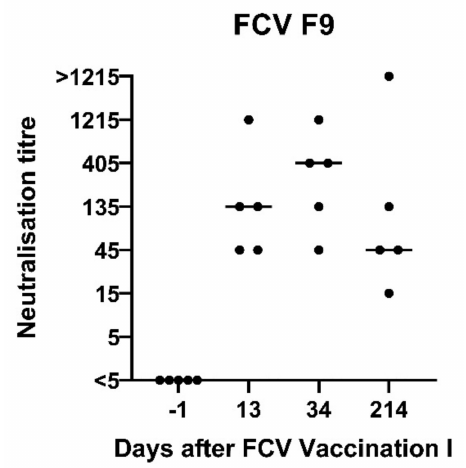
Figure 2. Dot plot of FCV F9 neutralisation titres in vaccinated cats after FCV Vaccination I with FCV F9. The titre is the reciprocal of the serum dilution where 50% or more of the wells show a CPE. Each dot represents the titre of a cat of the vaccine group. The horizontal bar represents the median. Days are indicated as days after the first injection of FCV Vaccination I. The second injection of FCV Vaccination I was performed at day 21 after the first